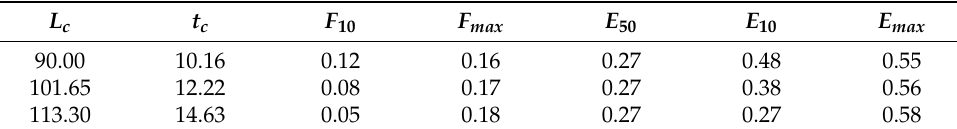
Table 3. Estimates of carapace length at first capture ( L c ; mm); age at first capture ( t c ; years); fishing mortality rate corresponding to 10% of the slope of the Y ′ /R curve at the origin ( F 10 ; year − 1 ); fishing mortality rate which produces the maximum Y ′ /R ( F max ; year − 1 ); exploitation rate under which the stock has been reduced to 50% of its virgin biomass ( E 50 ; year − 1 ); the optimal exploitation rate at which the marginal increase of Y ′ /R is 1/10 of its value at E = 0 ( E 10 ; year − 1 ); and maximum exploitation rate which gives the maximum Y ′ /R ( E max ; year − 1 ) estimated by Beverton–Holt method [47] for Palinurus elephas .